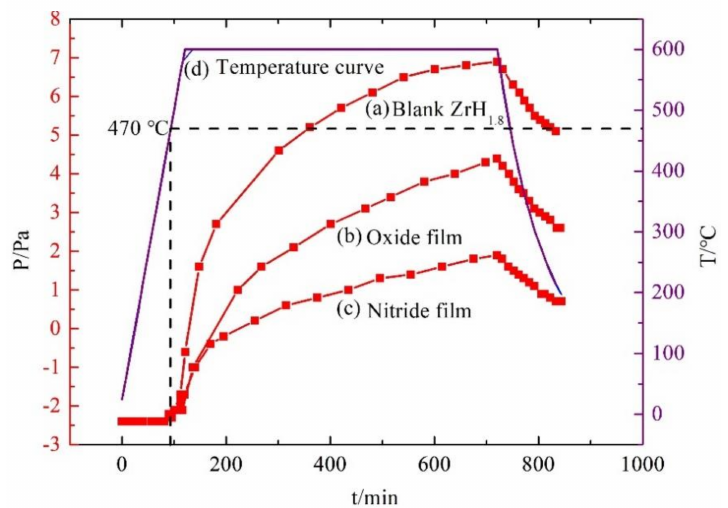
Figure 9. t-T-P curves of different films by vacuum thermal dehydrogenation: (a) Blank ZrH 1.8 ; (b) Oxide film; (c) Nitride film; (d) Temperature